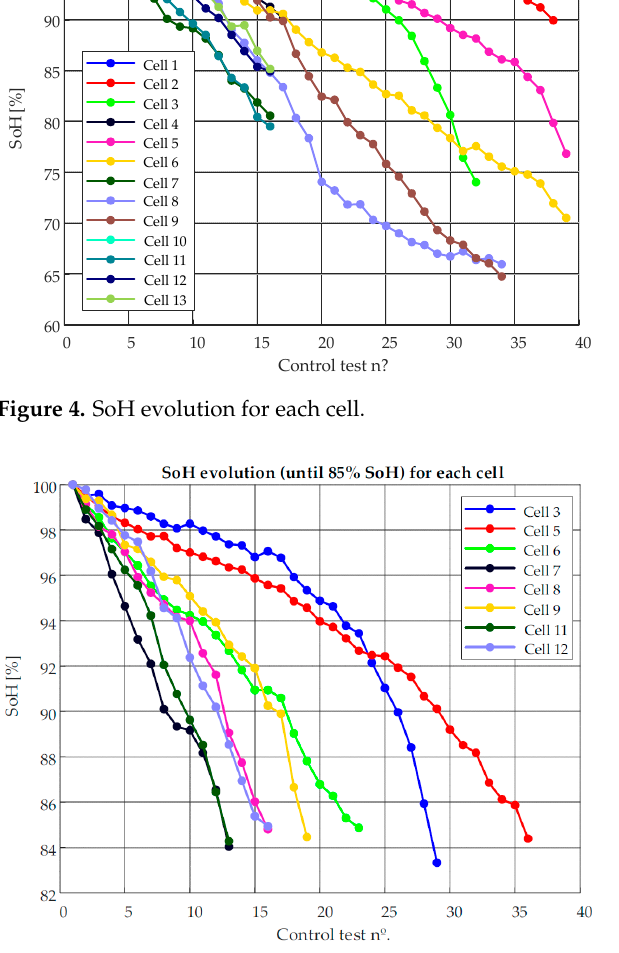
Figure 5. SoH evolution for each cell up to 85% of SoH.